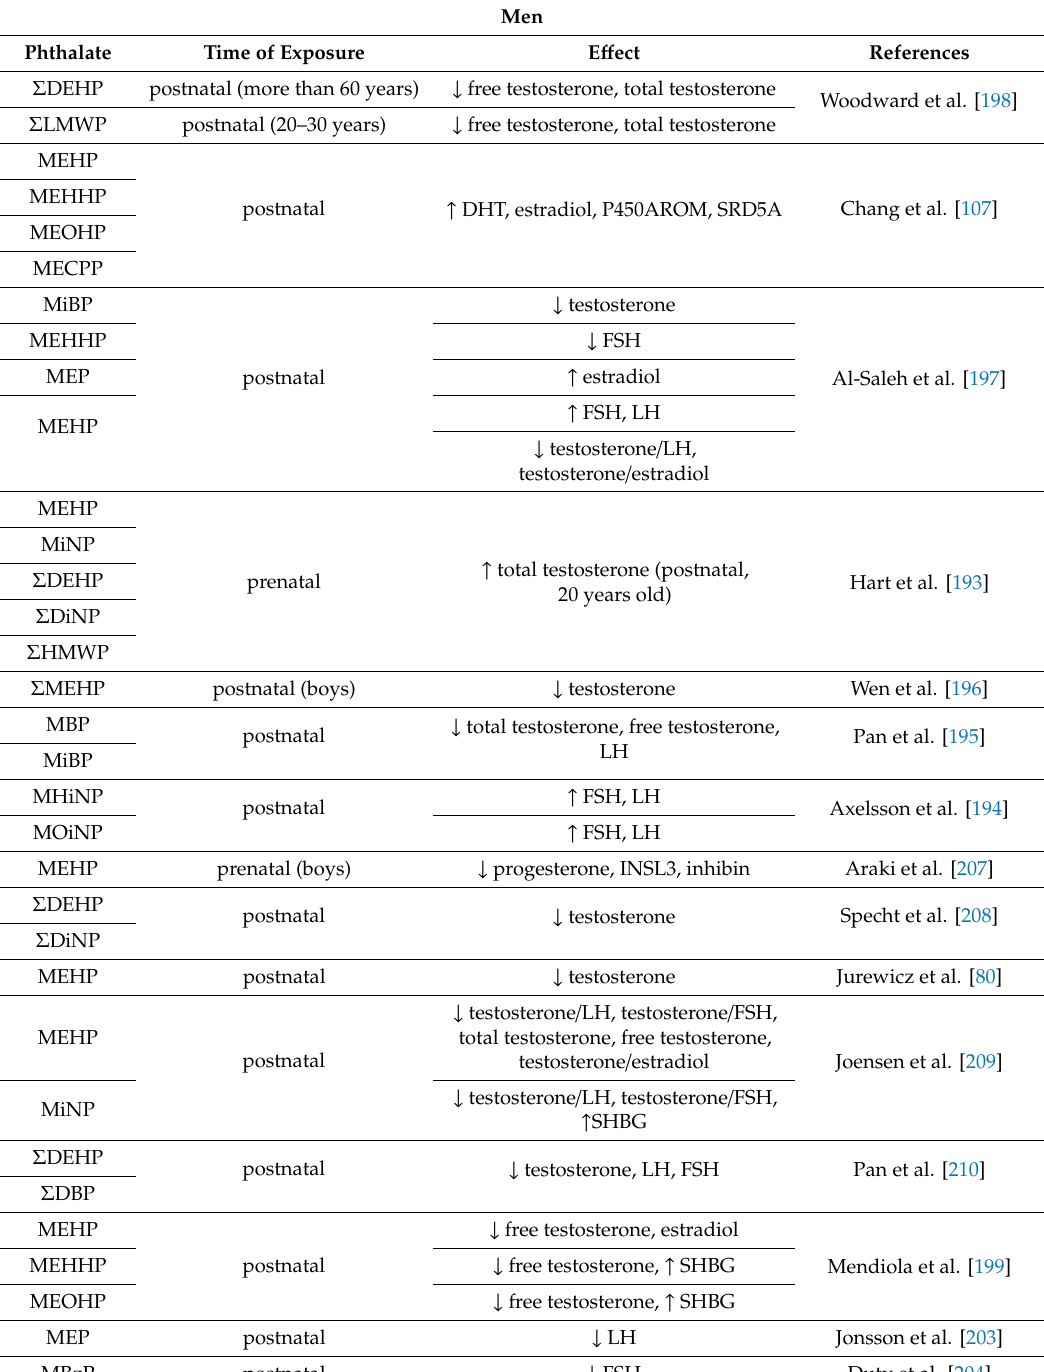
Table 4. Phthalates e ff ect on the HPG axis and steroidogenesis (epidemiological